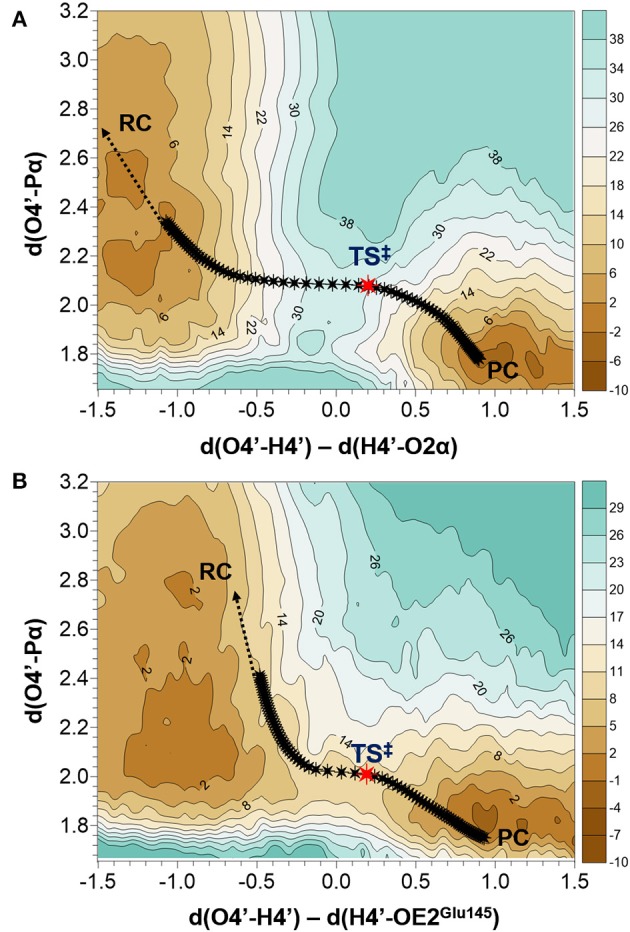
Potential energy surfaces obtained at AM1/MM level with superposition of located transition states and the projection of the reaction pathway obtained along IRC calculations obtained at M06-2X/MM level for (A) ATP-assisted and (B) Glu145-assuted mechanisms. Isoenergetic lines are given in kcal·mol−1 and distances in Å.